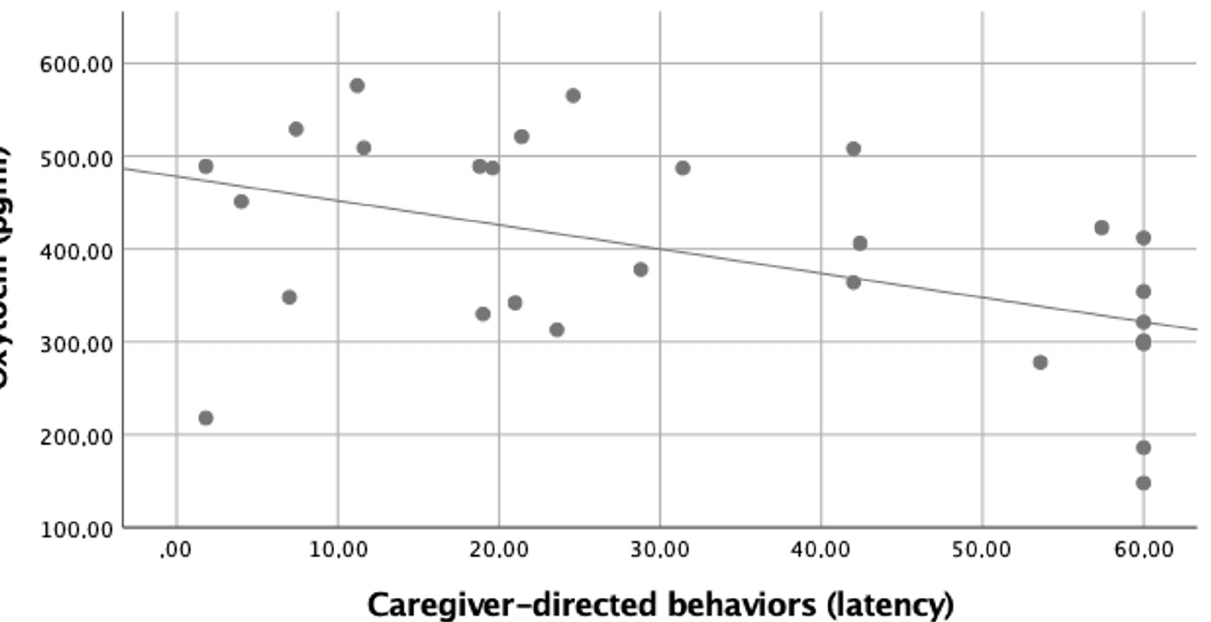
Figure 2. Simple scatter with fit line of serum oxytocin levels by the latency of the caregiver-directed behaviors. Spearman correlations between variables ρ = − 0.490 ( p = 0.042 with Bonferroni correction).